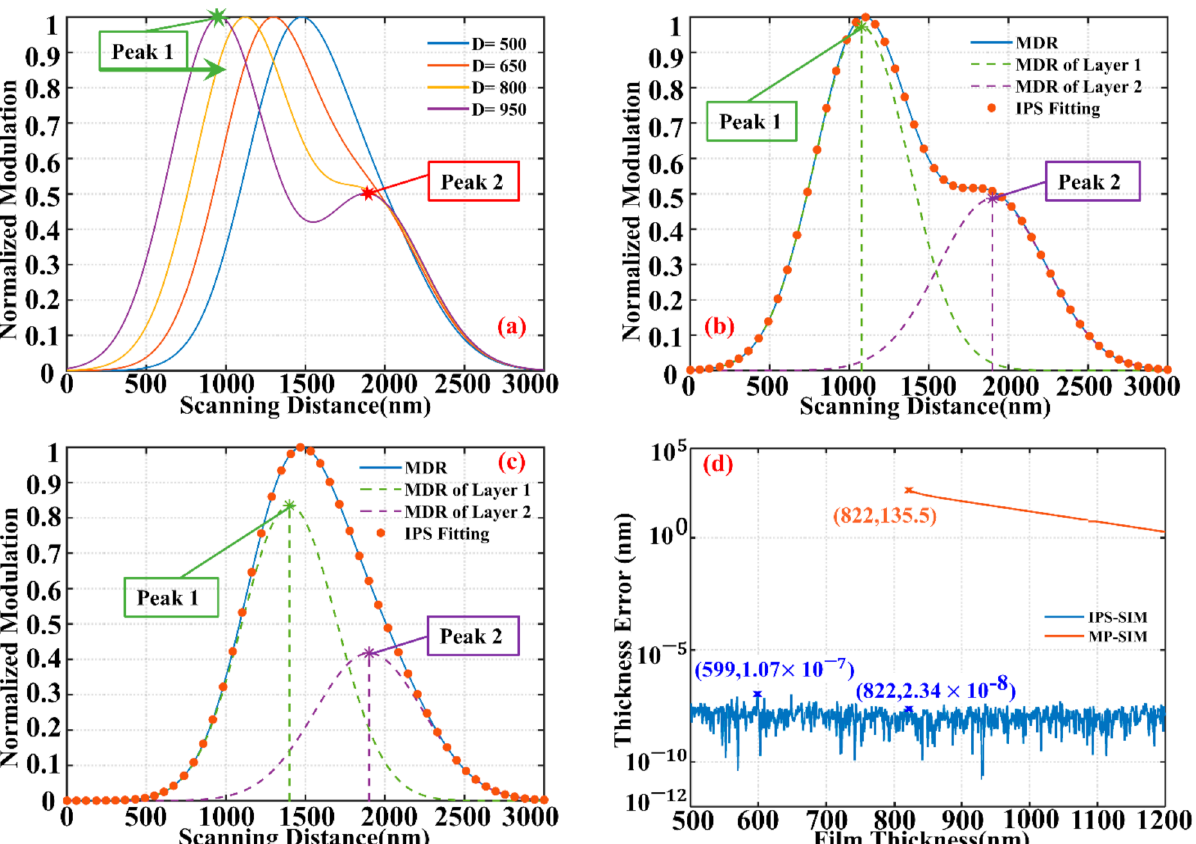
Figure 3. Comparison of the detection threshold of the iterative peak separation structured illumination microscopy (IPS-SIM) and the maximum-point-based SIM (MP-SIM): ( a ) the simulated MDR in different thickness D when FWHM 1 = 696 nm and FWHM 2 = 800 nm; ( b ) the fitting result by the IPS-SIM when the thickness is 822 nm; ( c ) The fitting curve by the IPS-SIM when the thickness is 500 nm; ( d ) the thickness measurement error as a function of film thickness in the IPS-SIM and